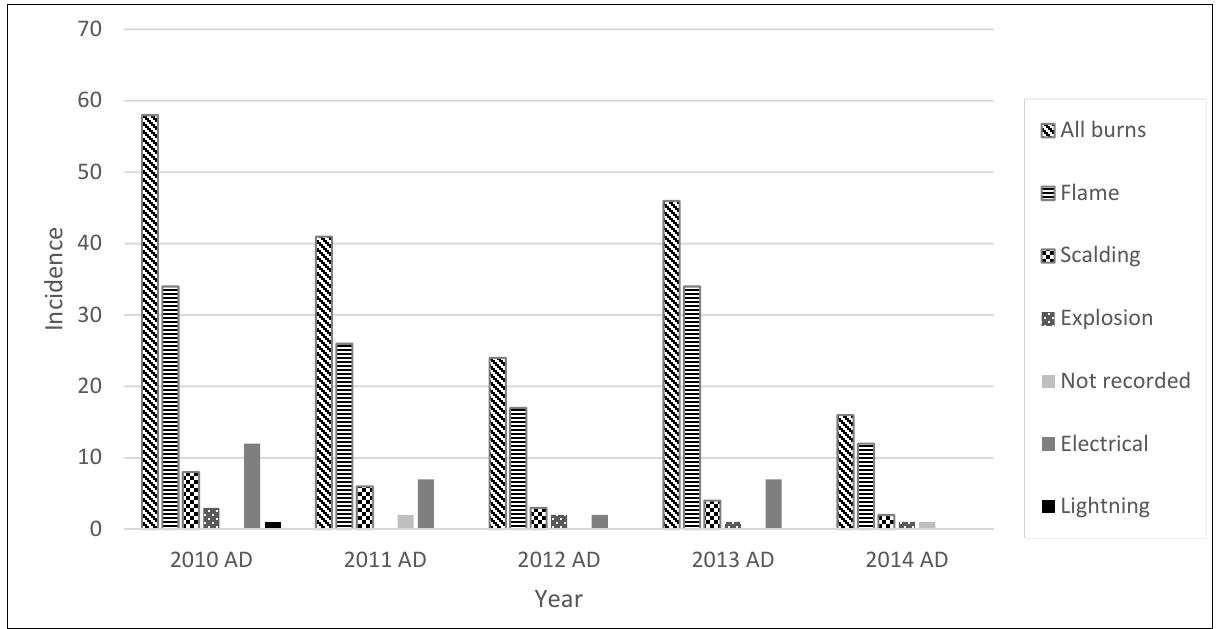
Figure 1: Yearly comparison of fatal thermal and electrical burn incidences in Johannesburg from 2010 to 2014.